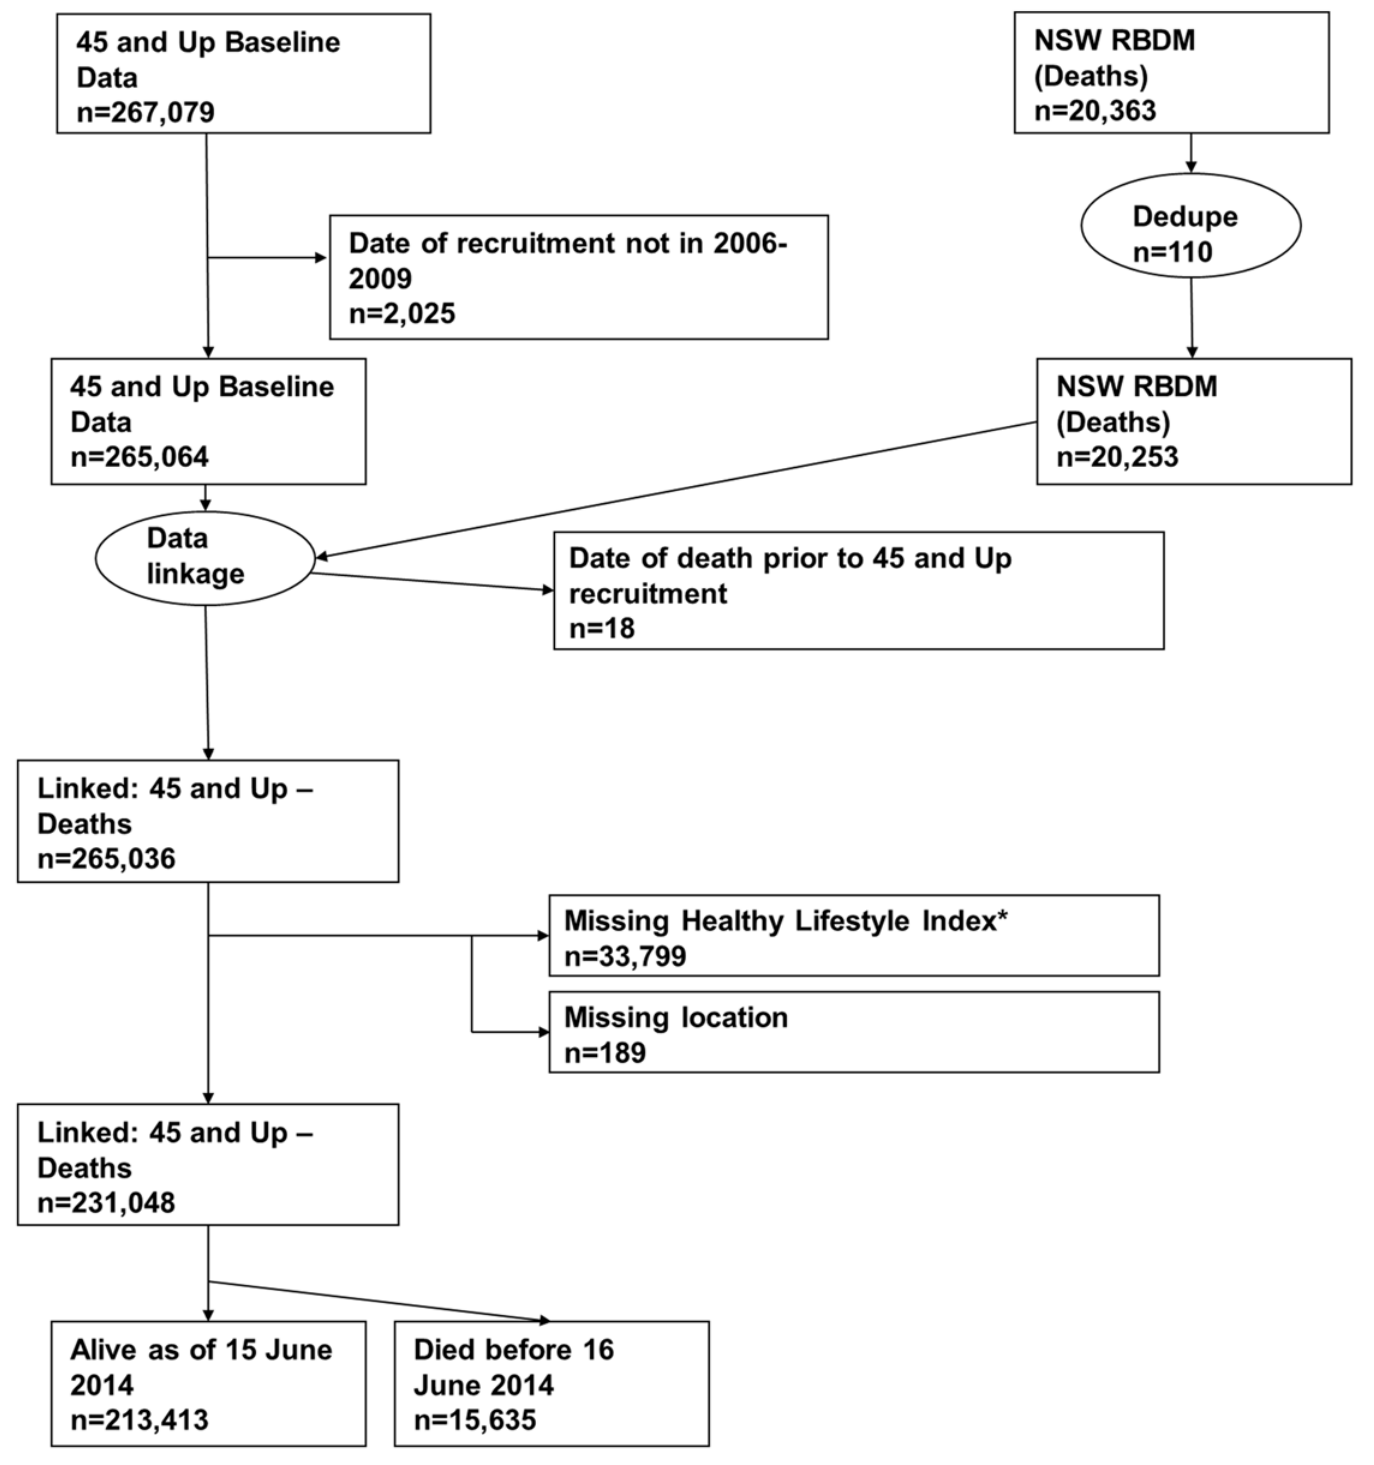
Fig 1. Participant flow diagram. * A risk index including smoking, alcohol use, dietary behavior, physical activity, sedentary behavior, and sleep duration. Dedupe, deduplicated.